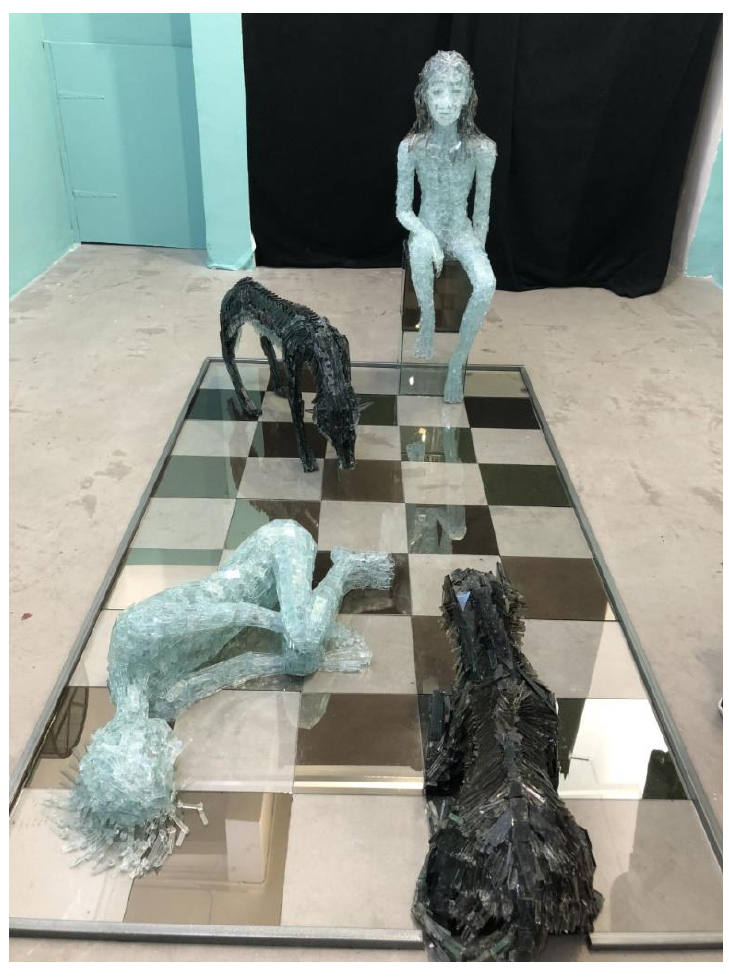
Figure 2. General view of installation 1700 km, 2019.